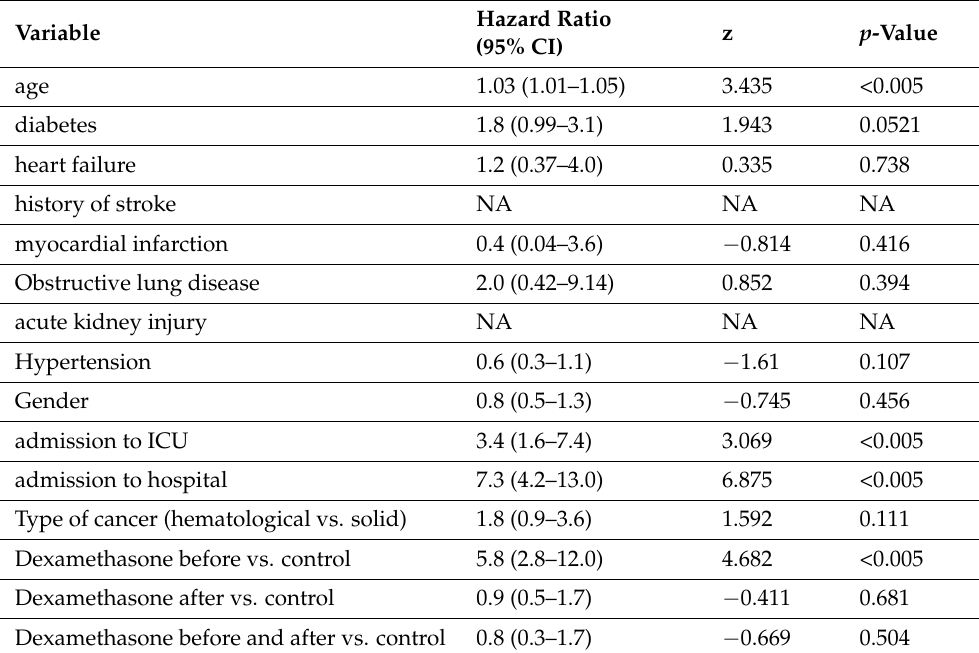
Table 5. Hazard ratios from multivariable Cox proportional hazards regression.